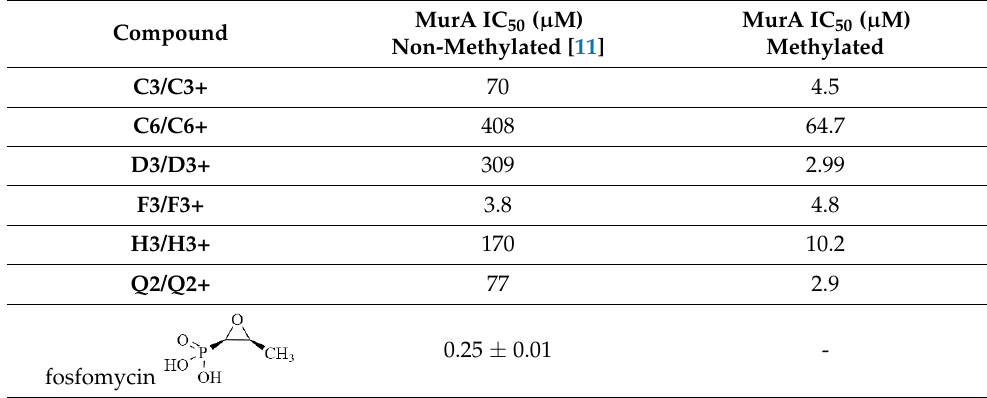
Table 1. Comparison of the most active methylated heterocycles with their first-generation matched pairs.